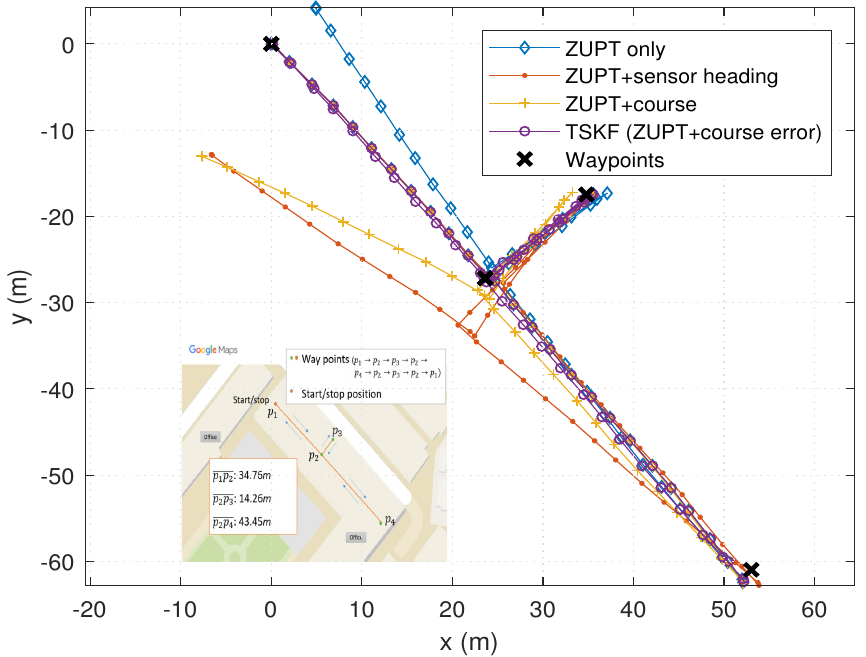
Figure 12. One of the indoor PDR